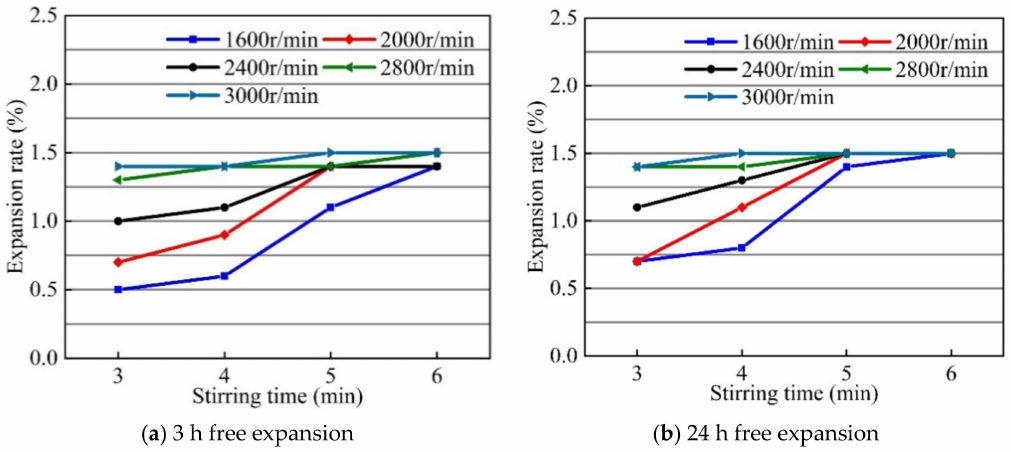
Figure 12. The expansion rates of crumb rubber grouts under different stirring rates and stirring